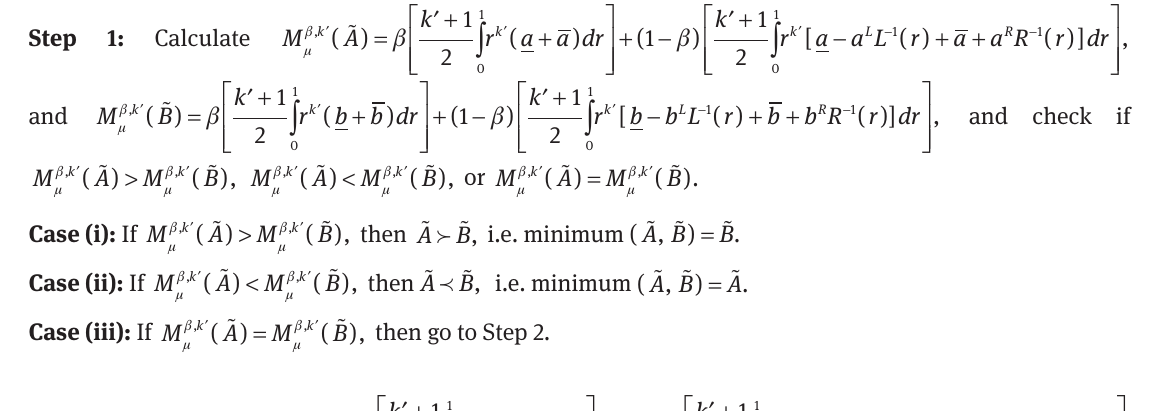
Table 7: Intuitionistic Fuzzy Passing Time 2 ( ).